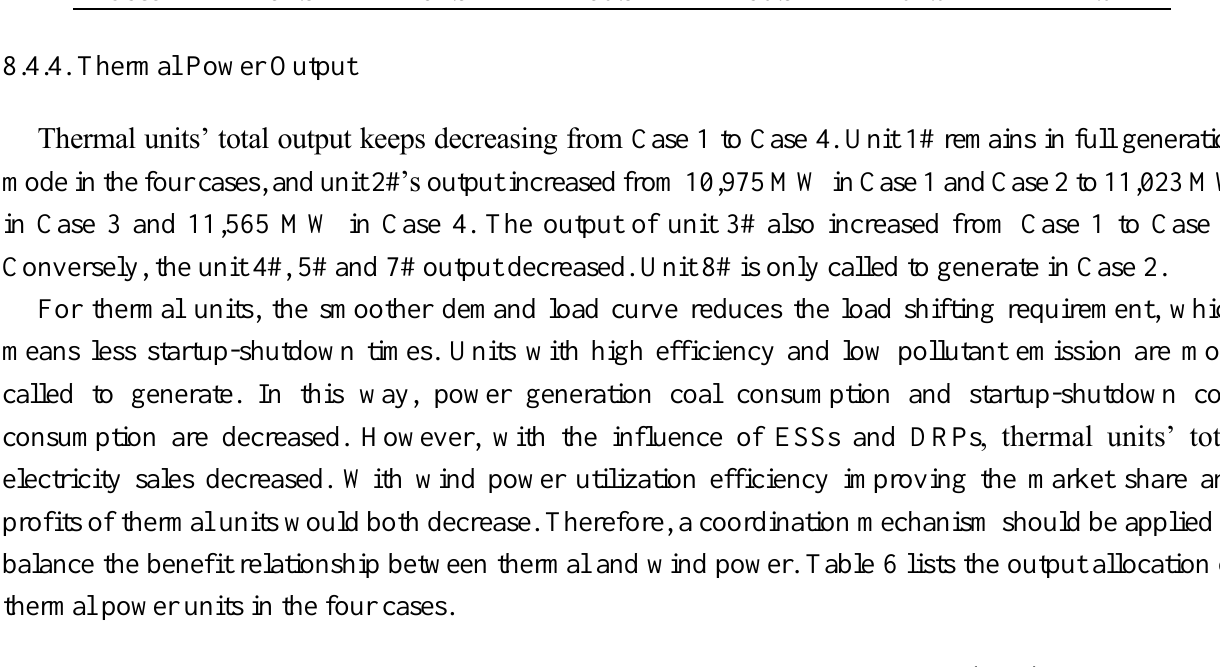
Table 6. Output allocation of thermal power units in four cases